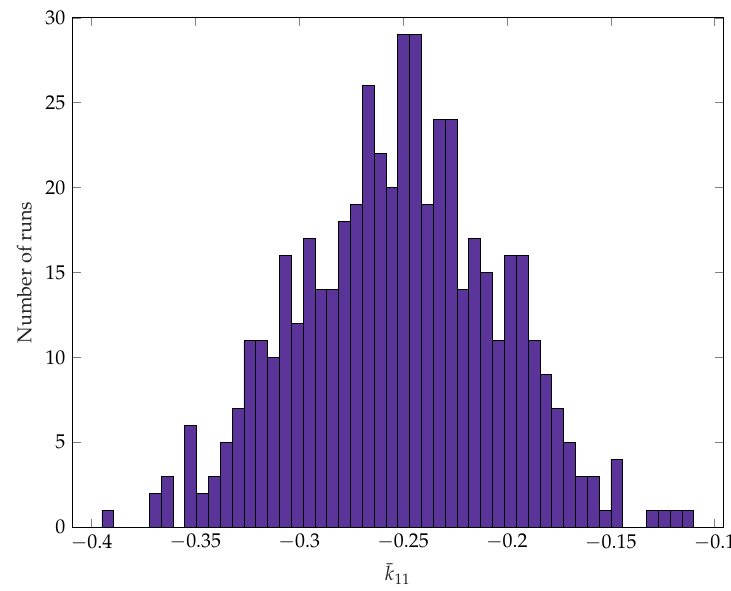
Figure 8. Histogram of the parameter ¯ k 11 during 500 Monte Carlo runs.